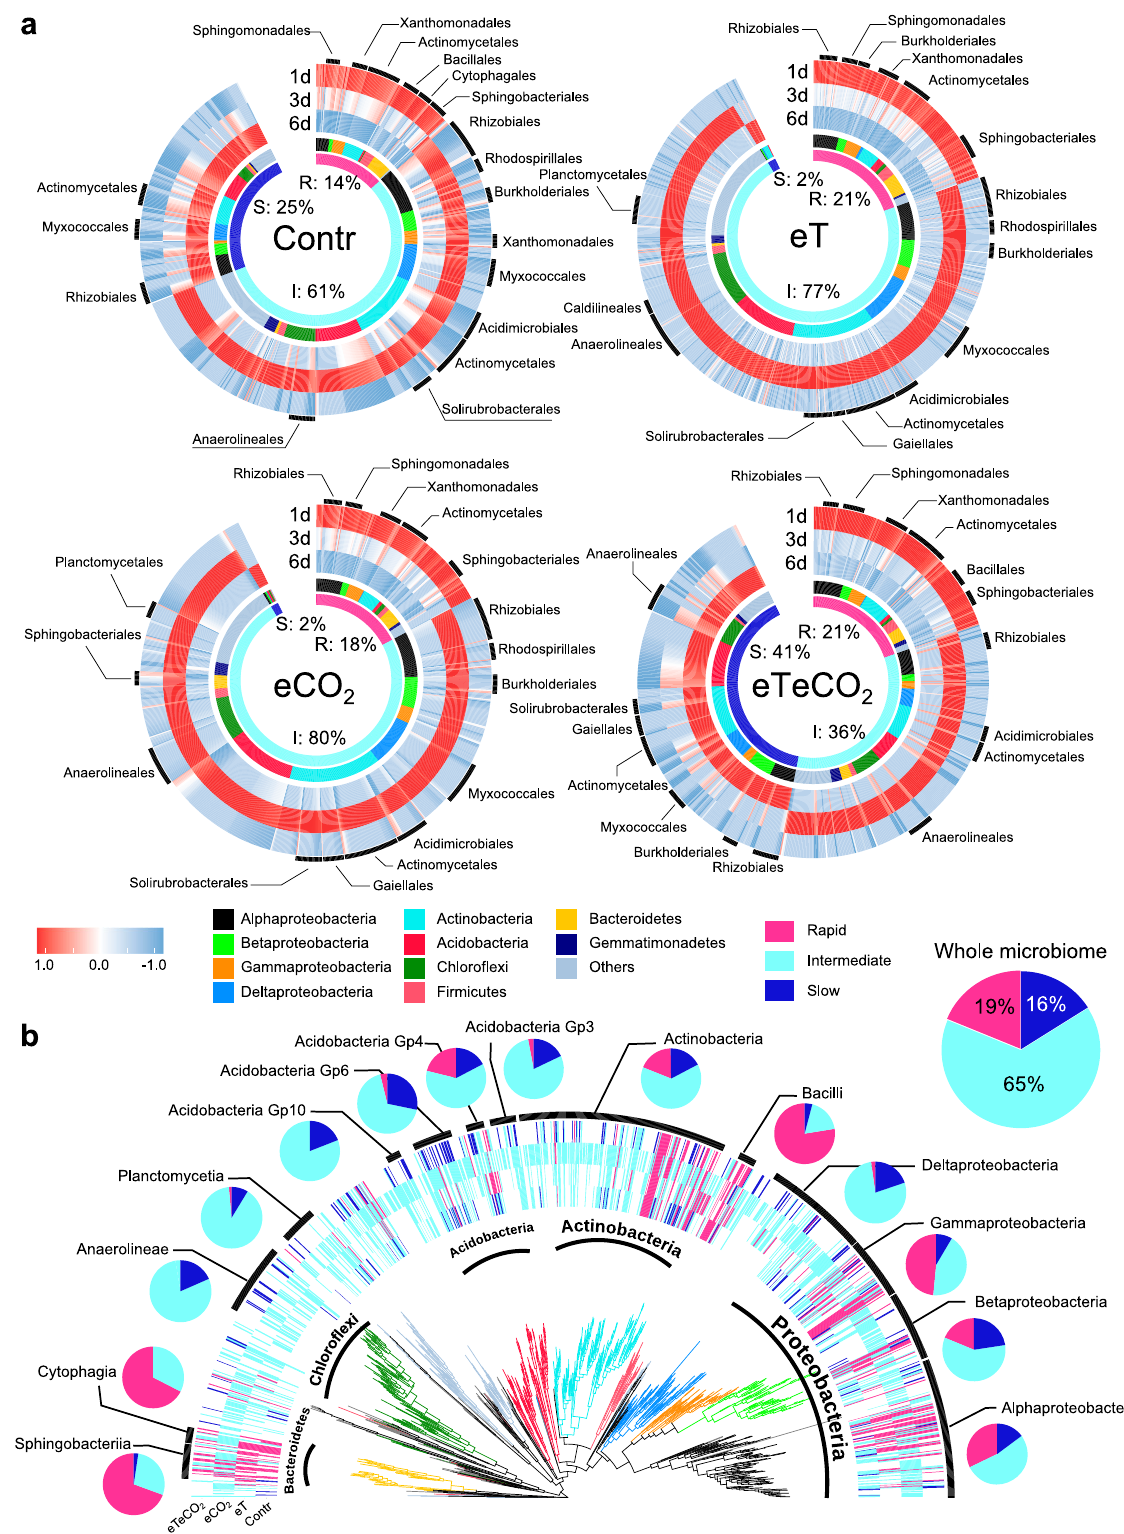
Fig. 3 | Taxawithdistinct growthstrategies. We de fi ned three growth strategies: rapid, intermediate, and slow responses. The heatmap showed the growth dynamics of taxa across the incubation period (the values were Z-score standar- dized and rangedfrom − 1to 1)( a ). Growthstrategiesofbacterialtaxainrelationto phylogeny ( b ). The pie charts represent the proportion of responders at the class level using data from all four treatments. The total proportion of growth response